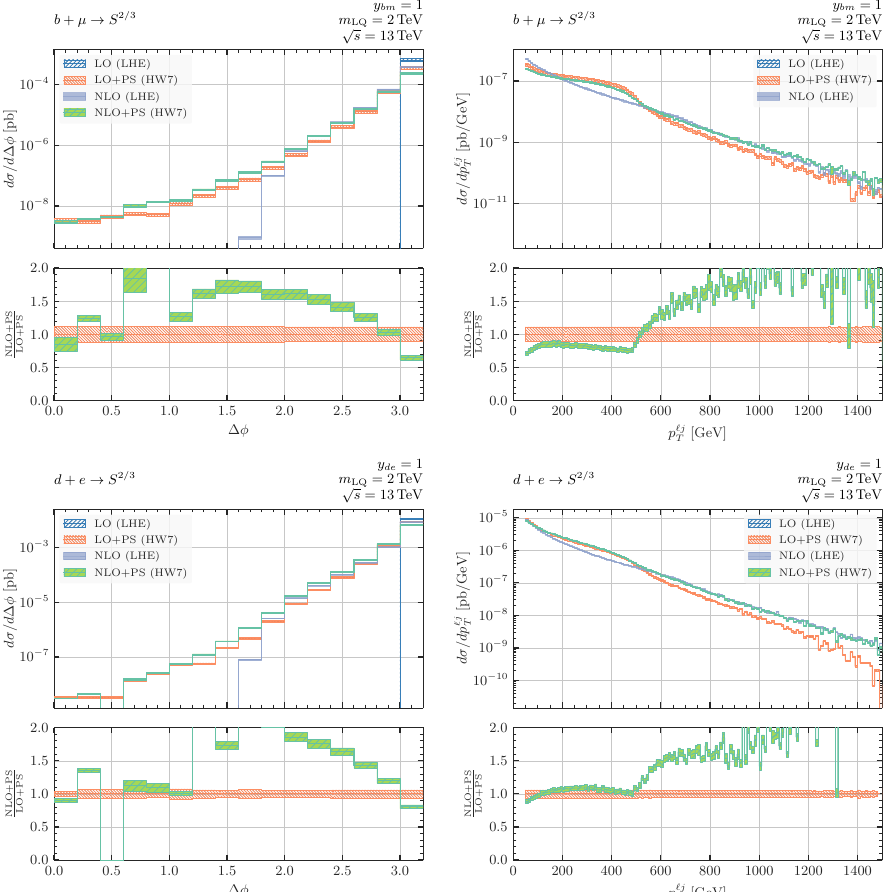
Figure 3 . Differential distributions for the benchmark points defined in section 3.2. The left panel shows ∆ φ between lepton and jet, and the right panel shows the jet-lepton system’s transverse momentum p lj T